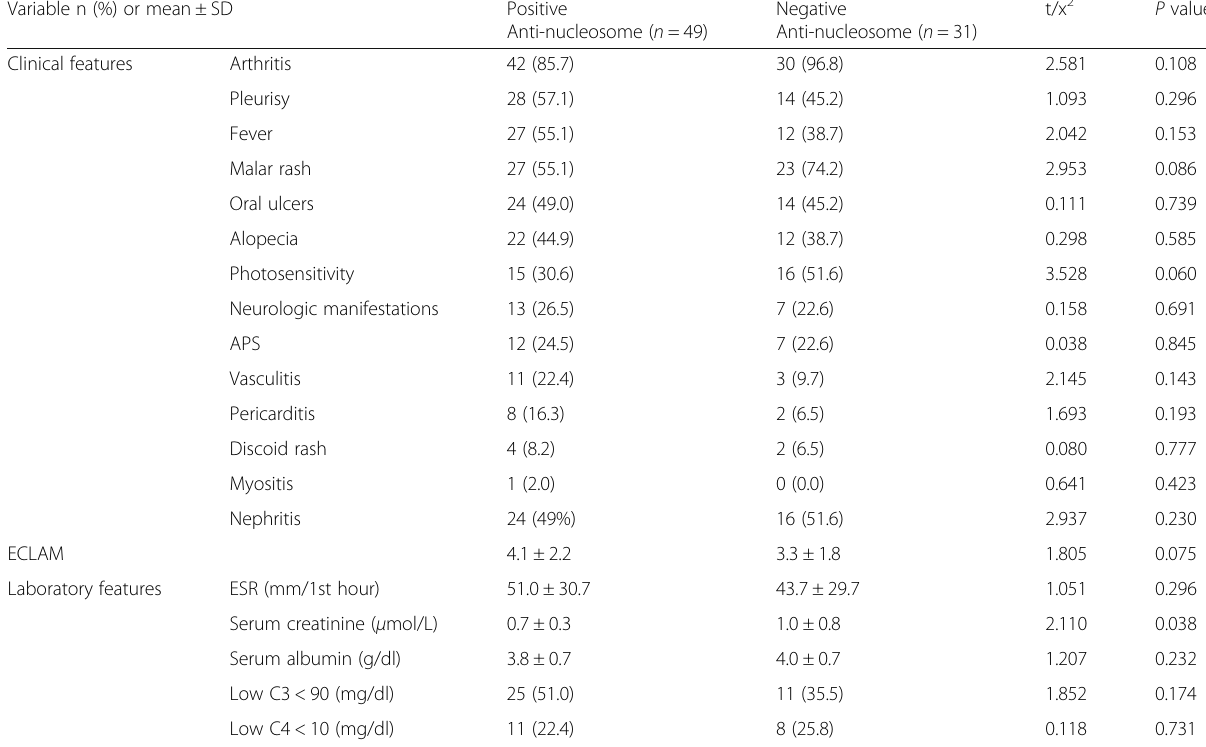
Negative t/x 2 P value Anti-nucleosome ( n = 49) Anti-nucleosome ( n = 31)